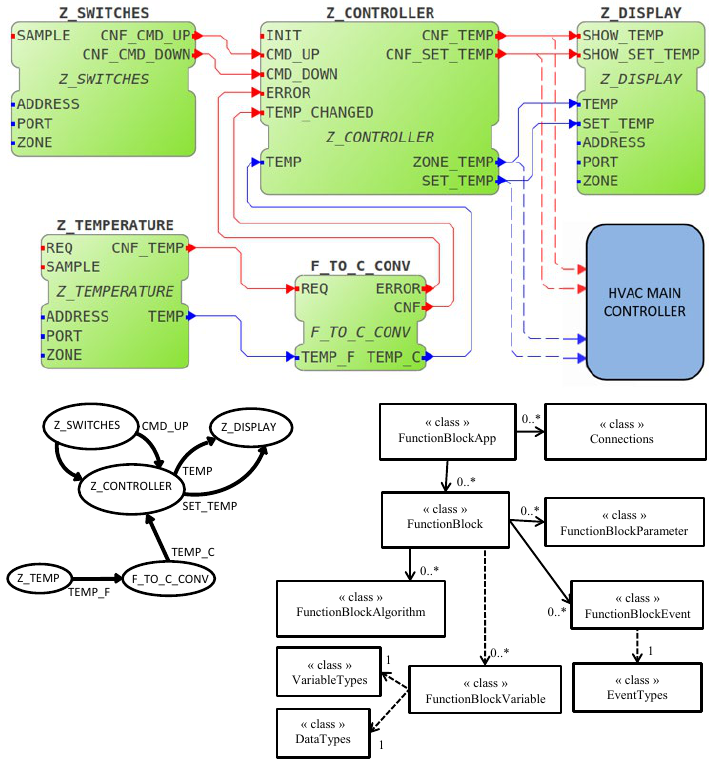
Figure 10. An FB application as a Directed Graph and the Function Block Node